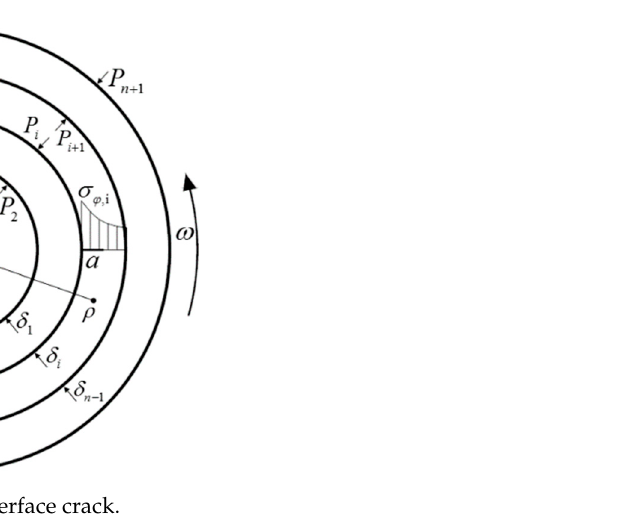
Figure 8. MRWC with an interface crack.